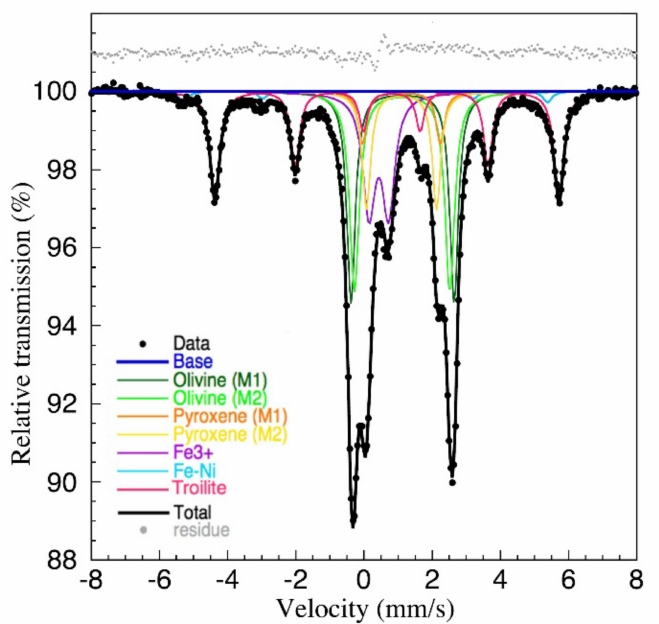
Figure 28. Room temperature Mössbauer spectrum of ordinary chondrite MIL 07710 L4. Indicated components are the result of the fit. The differential spectrum is shown on the top. Adapted from Reference